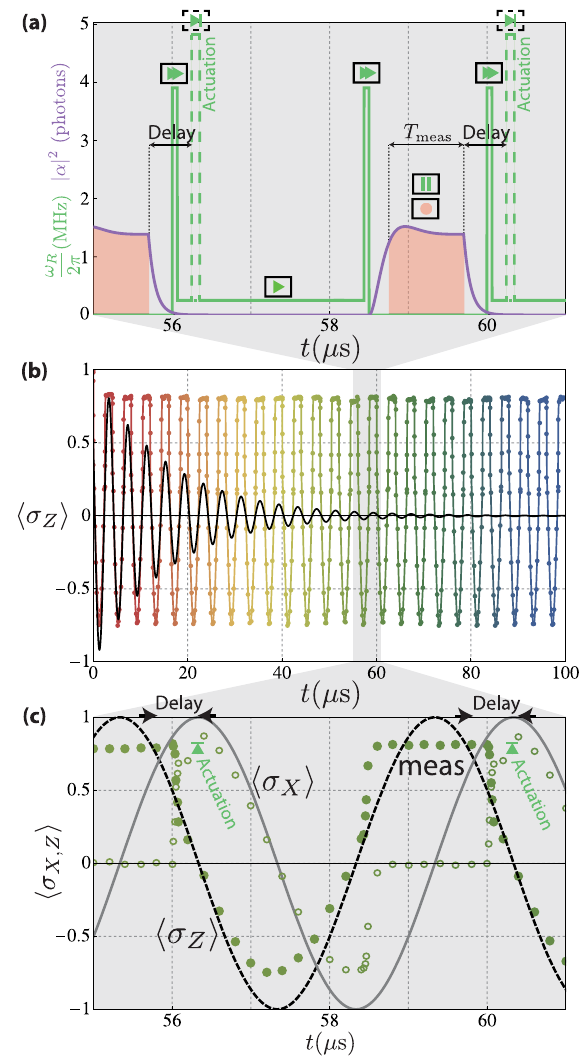
FIG. 3. (a) Pulse sequence for stabilizing Rabi oscillations. For a typical period of 4 (cid:1) s , the green line represents the drive amplitude and the purple line the expected occupation of the cavity. The complex amplitude a of the measurement field is recorded only during the steady part of the occupation (red areas). When Im ð a Þ > 0 , a fast (cid:2) pulse is applied after a total delay of 500 ns (actuation). These steps are illustrated with the usual symbols for a media player. (b) The black line with fre- represents the decaying Rabi oscillation around (cid:10) Y ¼ 250 kHz and measured decay time T ¼ 15 : 5 (cid:1) s . quency ! R R The dots on the line represent persistent Rabi oscillations mea- sured using the pulse sequence described in (a). (c) Same i (filled measurement as in (b) shown on a smaller span for h (cid:10) Z i (open circles). The targeted Rabi trajectory is dots) and h (cid:10) X i and a solid gray shown as two lines, a dashed black line for h (cid:10) Z i . one for h (cid:10) X